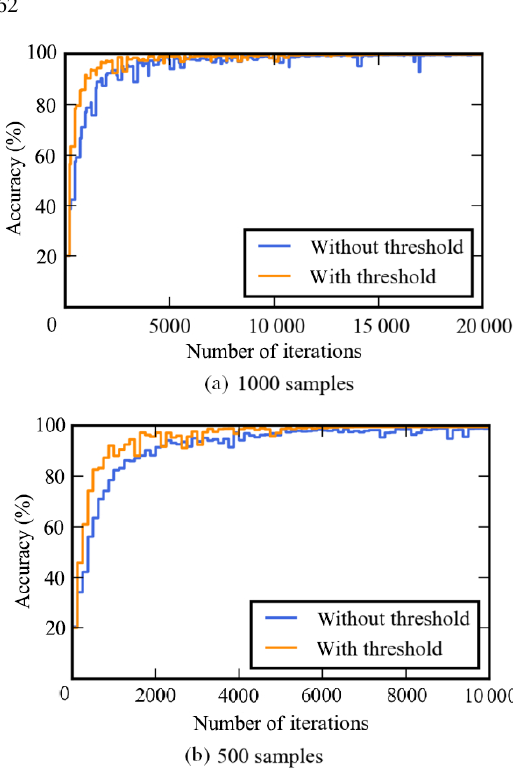
Fig. 10 Comparisons with/without threshold under different capacities of limited labeled datasets in Case 2.